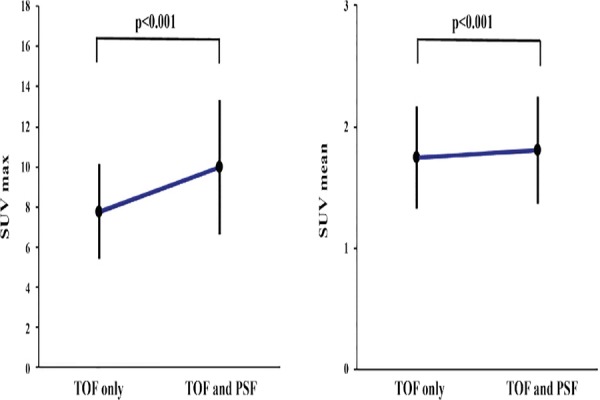
Effect of the concomitant use of time of flight (TOF) and point spread function (PSF) on SUVmax and SUVmean in 41 clinical cases